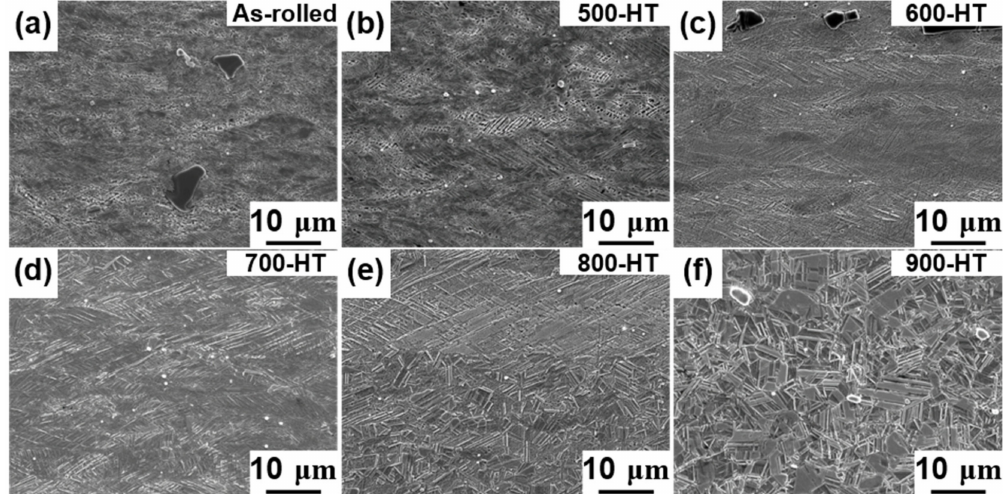
Figure 3. Scanning electron microscope (SEM) images ( × 2000) of Fe-SMA in different heat-treatment conditions. Rolling direction is horizontal to the images; ( a ) as-rolled, ( b ) 500 ◦ C heat-treated, ( c ) 600 ◦ C heat-treated, ( d ) 700 ◦ C heat-treated, ( e ) 800 ◦ C heat-treated, and ( f ) 900 ◦ C heat-treated.